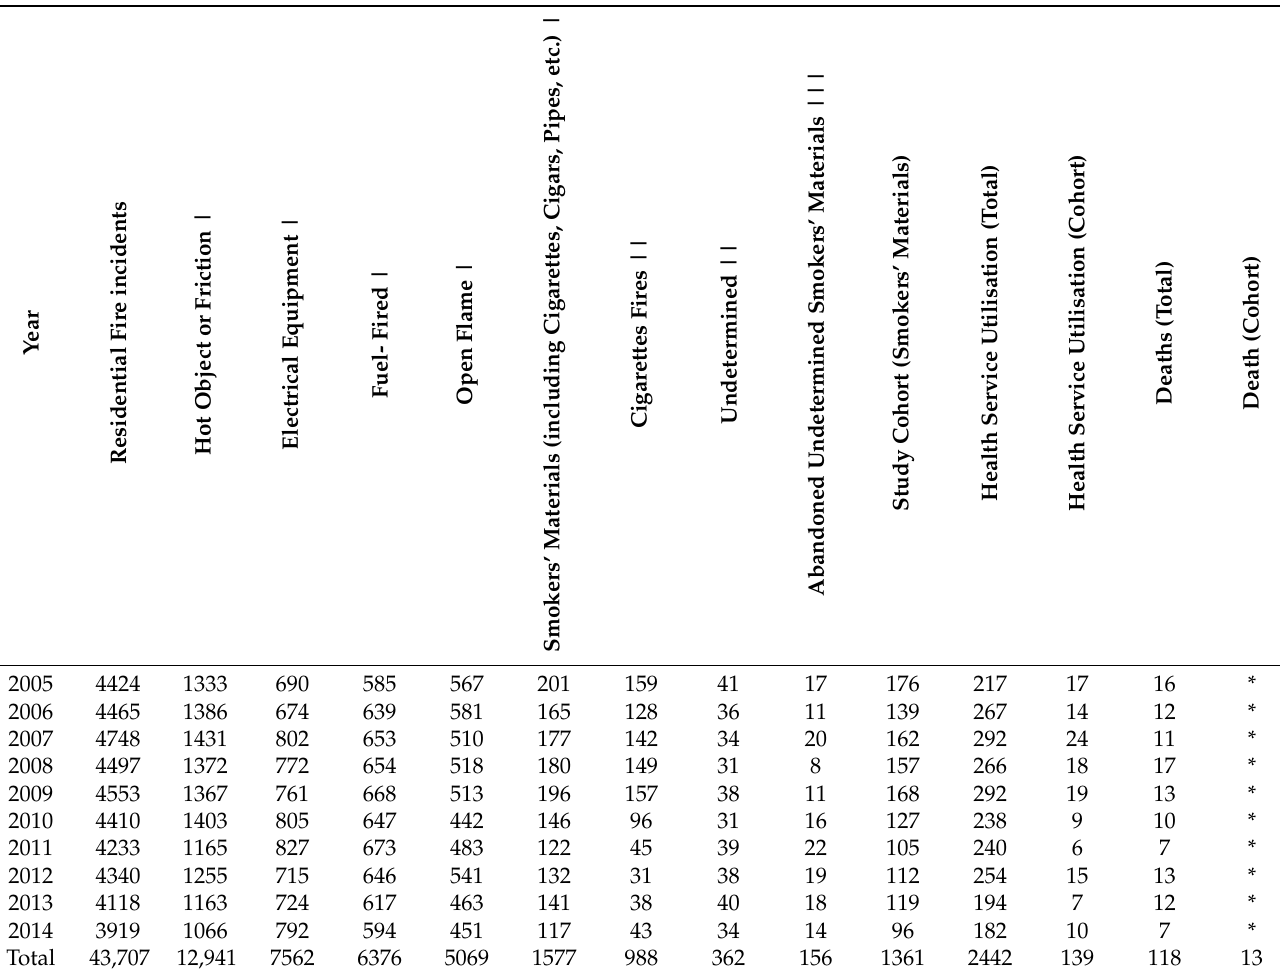
Table 1. Number of residential fire incidents and associated health utilisation services and deaths using FRNSW AIRS linked to health administrative dataset, NSW, Australia,